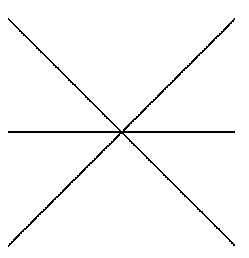
Figure 1 . A Feynman diagram without any internal propagator, contributing to n -point amplitude. cated Feynman diagrams with internal propagators that also contribute to the